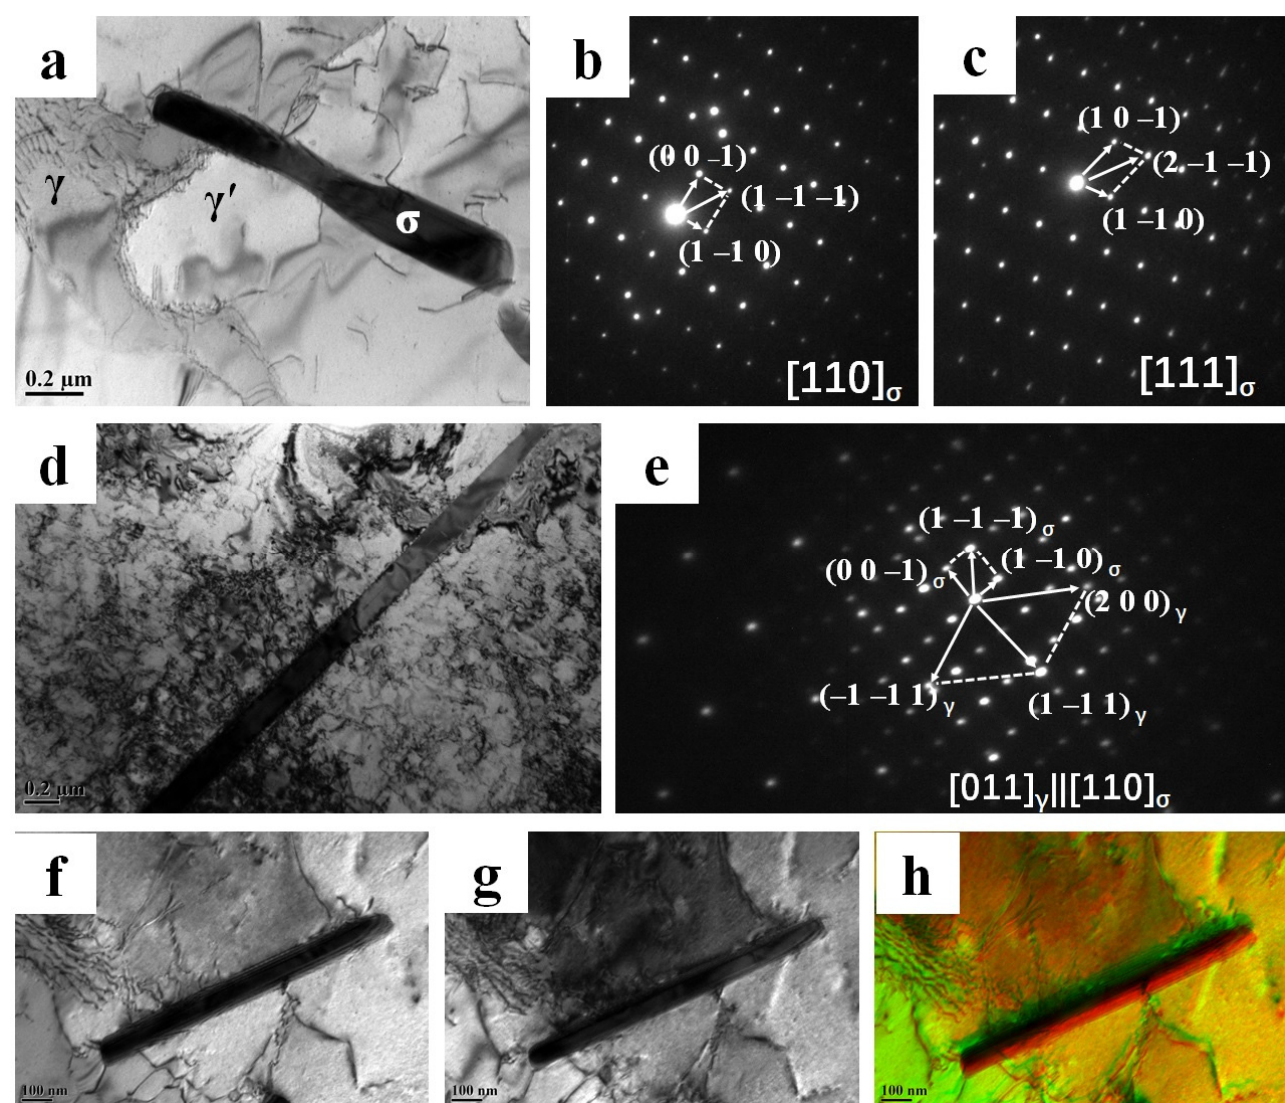
Figure 9. TEM results of the region which is 10 mm away from the fracture surface; ( a ) bright field image showing the interaction of σ phase and dislocations; ( b ) diffraction pattern of σ phase with the beam from [1 1 0] direction; ( c ) diffraction pattern of σ phase with the beam from [1 1 1] direction; ( d , e ) bright field image and diffraction pattern showing the interface between σ phase and γ matrix; ( f ) bright field image with beam close to [1 1 0] direction; ( g ) bright field image with ~6° α tilt; ( h ) merged image of ( f , g ).